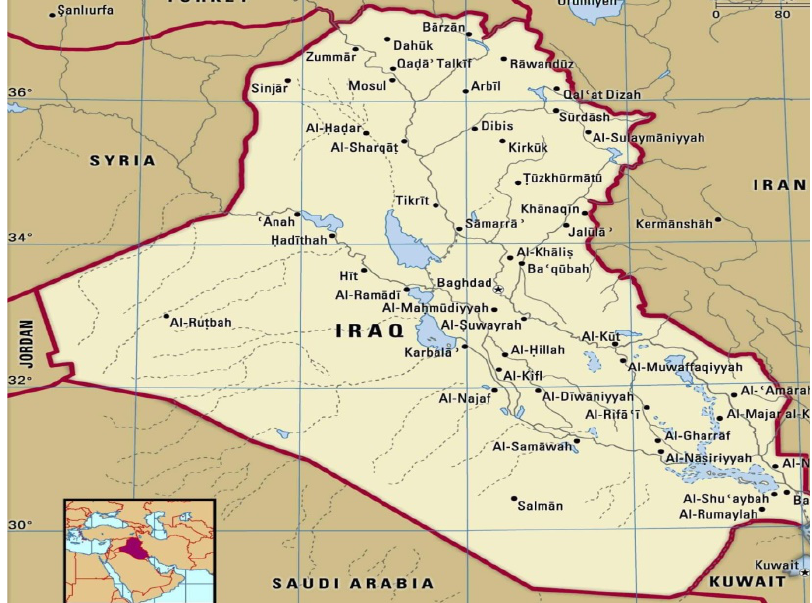
Fig.2: Representing the map of Iraq through which the dust storm from neighboring countries